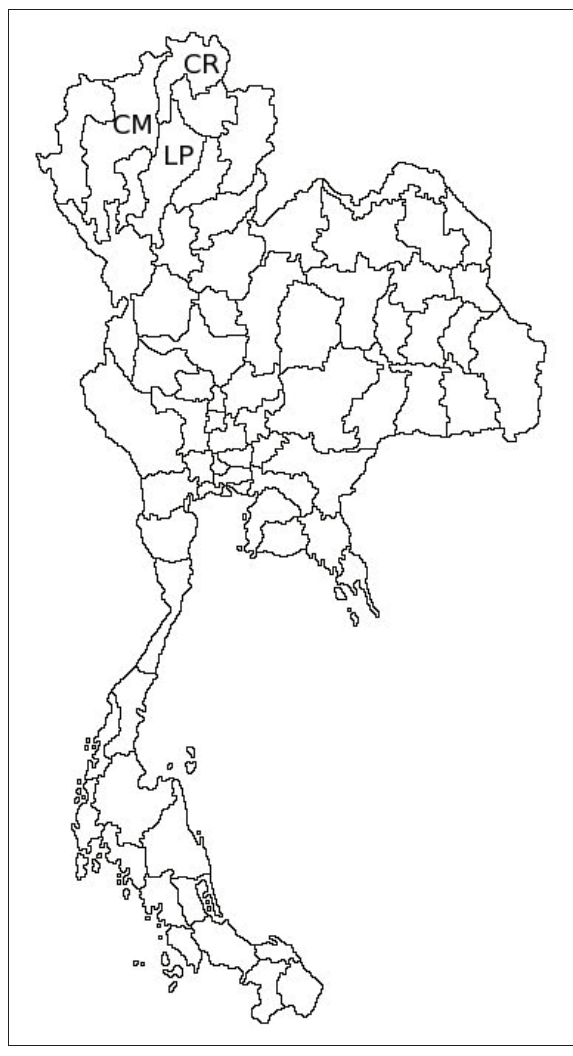
Map of Thailand showing the location of the three prov- inces from which blood samples were collected: Chiang Mai Prov ince (CM), Chiang Rai Province (CR) and Lumpang Province